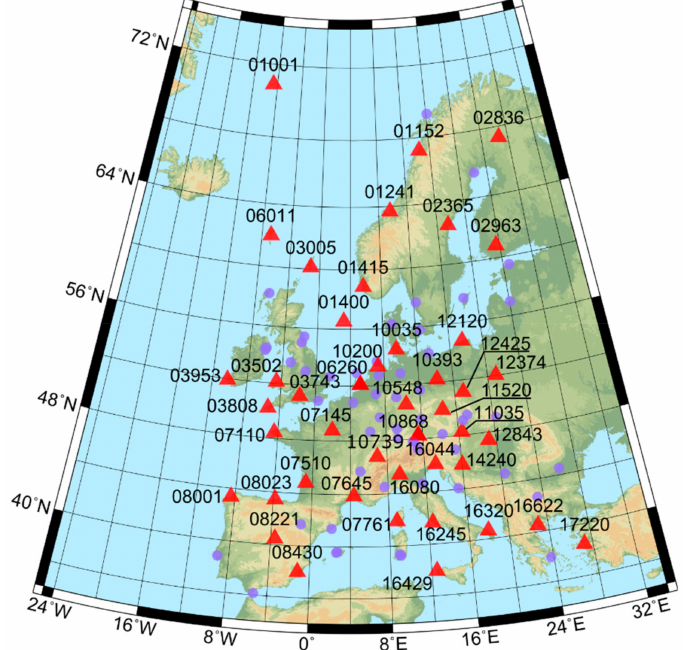
Figure 1. Distribution of the radio-sounding (RS) stations used in the study. The red triangles denote stations from the estimation group, whereas the light violet circles denote stations from the external group. The station number is assigned to the station from the estimation